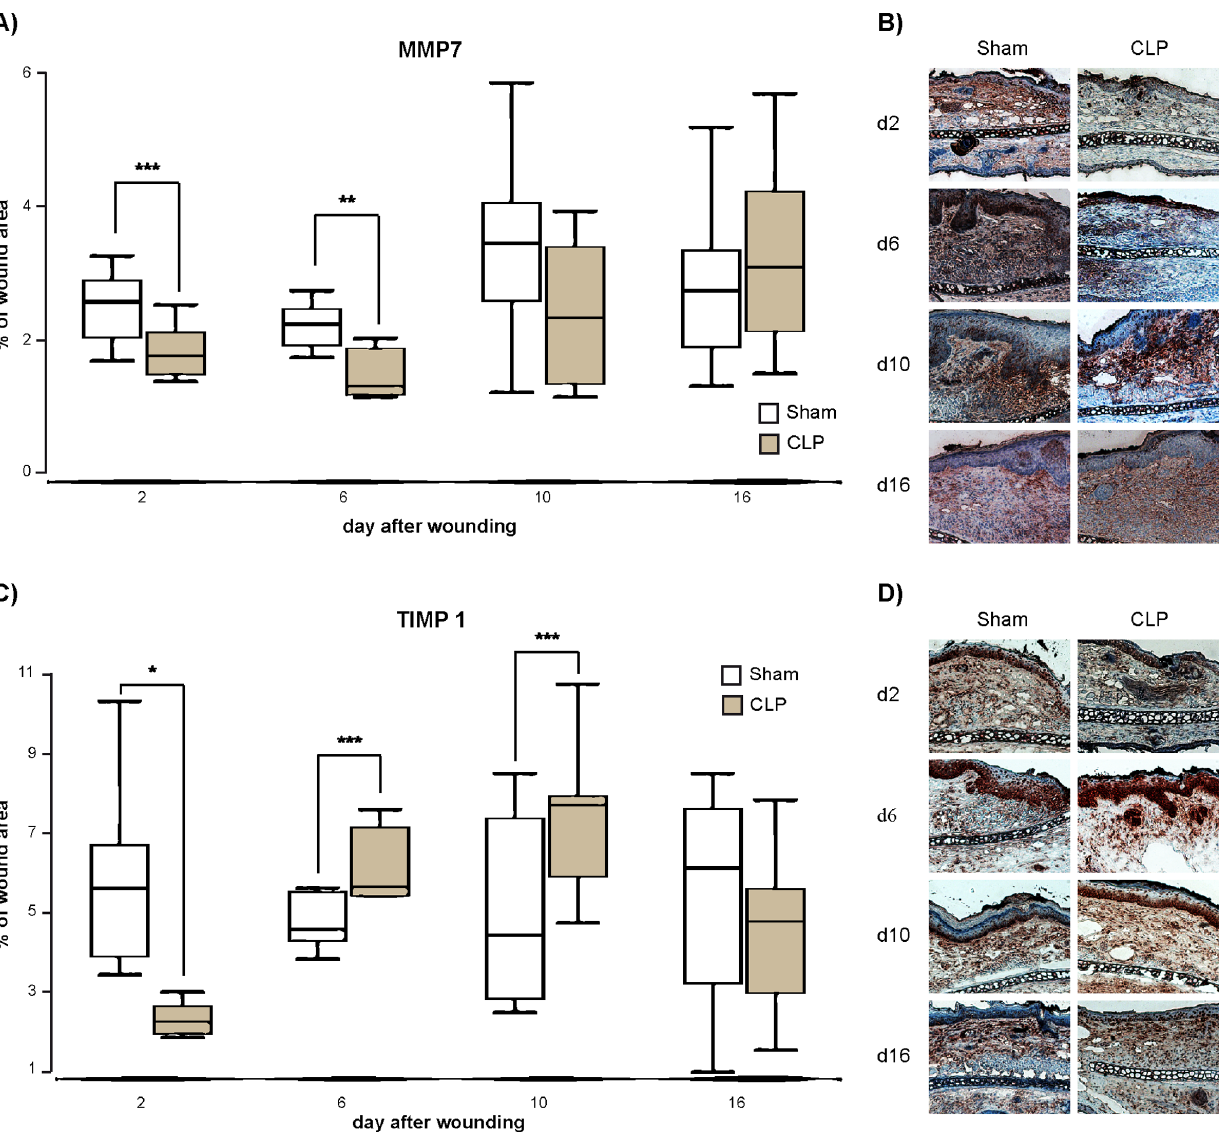
Figure 4. Expression of MMP7 and TIMP1 in wounds. A. Percentage of MMP7-positive area on days 2, 6, 10 and 16 after wounding. Septic animals show a significant decrease in MMP7 expression on day 2 and 6 compared to control mice. B. Representative pictures of MMP7 staining at the wound margin captured under 100x magnification of sham and CLP animals on day 2, 6, 10 and 16 after staining for MMP7. Wound margin is located on the right side. C. Percentage of TIMP1-positive area on days 2, 6, 10 and 16. TIMP1 was significantly decreased on day 2 after wounding after CLP. In the later phases of wound repair a significant increase of TIMP1 was observed in septic mice compared to control animals. D. Representative pictures of TIMP1 staining at the wound margin captured under 100x magnification of sham and CLP animals on day 2, 6, 10 and 16 after staining for TIMP1. Wound margin is located on the right side. (Data are expressed as box plots of the median n =8). * p , 0,001, ** p , 0,01, * p , 0,05.